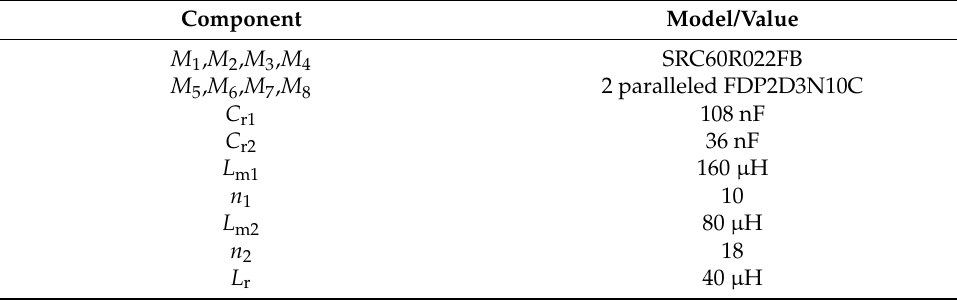
Table 1. Parameters of the DHC-LT